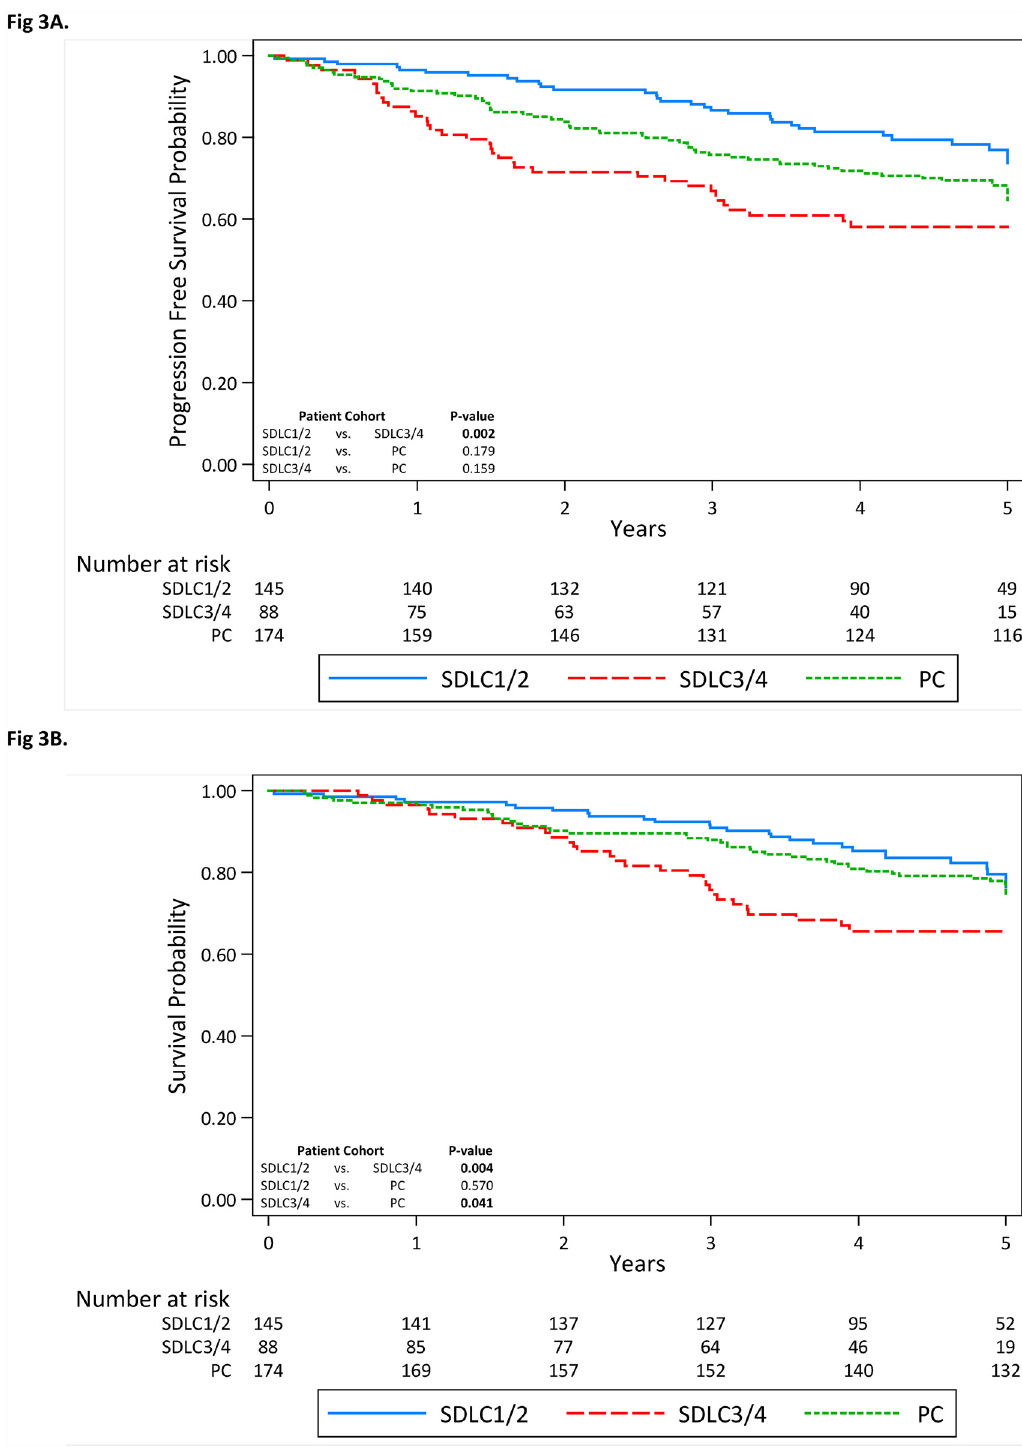
Fig 3. Kaplan-Meier estimates and number of subjects at risk in stage I and II patients for (A) progression free survival and (B) overall survival in the prevalence-, interval-, and grouped screen-detected lung cancers. Abbreviations: SDLC1/2 = Combined screen-detected incidence lung cancers following positive screens at T1 and T2 rounds in cohorts with T0 positive screens; SDLC3/4 = Combined screen-detected incidence lung cancers following positive screens at T1 and T2 rounds among cohorts with T0 or T0 and T1 negative screens.